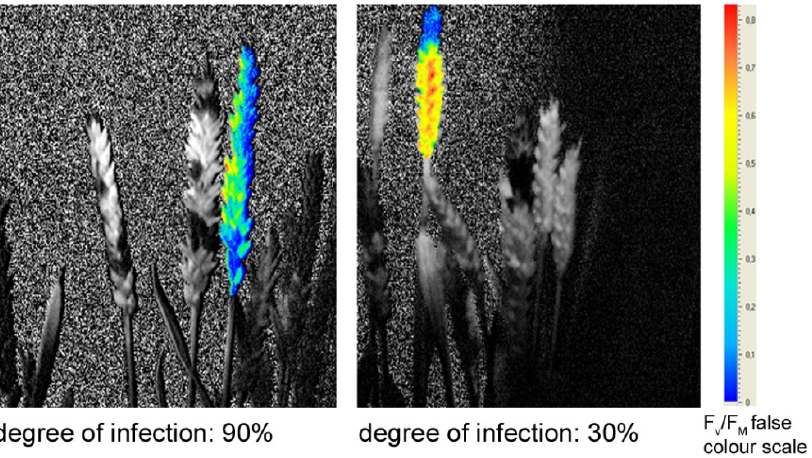
/F distribution on wheat heads infected at largely different v m